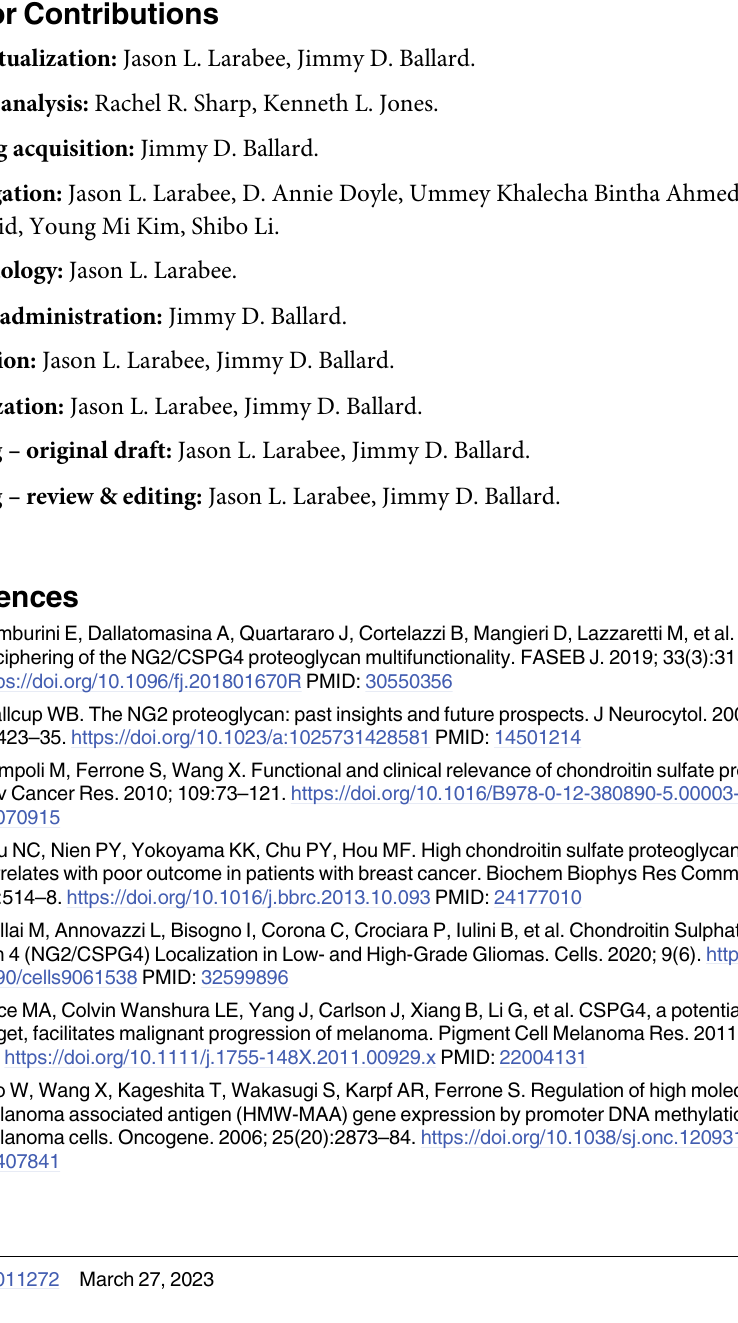
S1 Table. In vitro growth of C . difficile strain R20291 in the presence and absence of